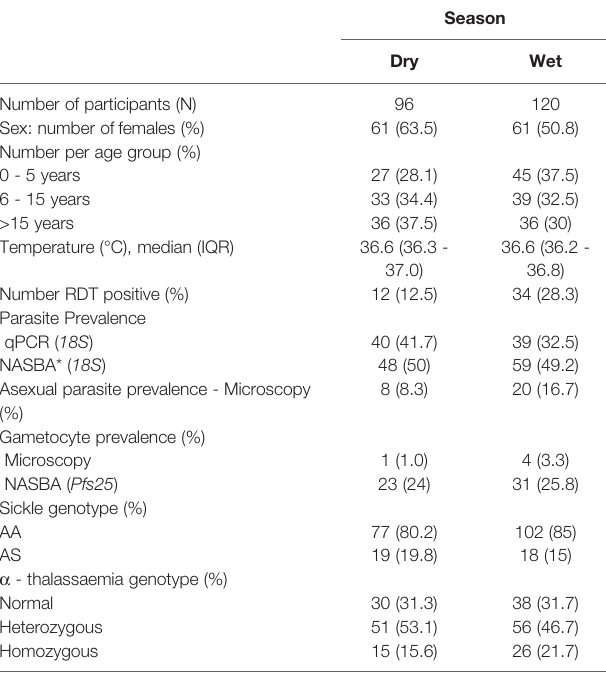
TABLE 3 | Demographic characteristics of participants from the AFIRM cohort